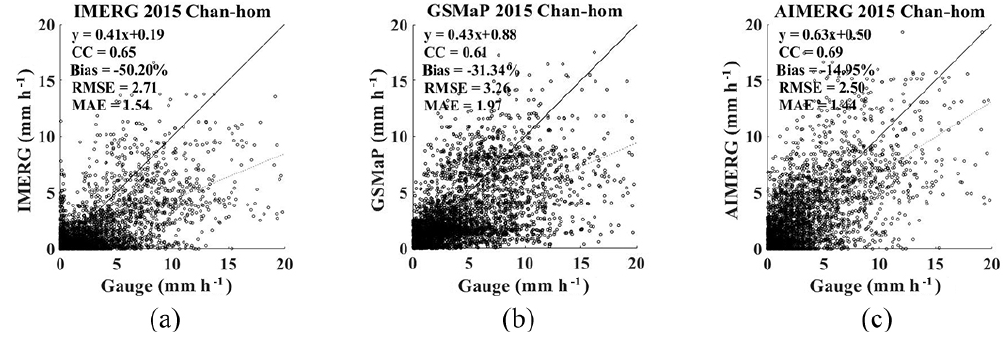
Figure 12. The scatterplots of (a) IMERG, (b) GSMaP, and (c) AIMERG against ground observations during the typhoon, Chan-hom, which occurred in the typical period 00:00–11:00 on 11 July 2015 in the Zhejiang province.